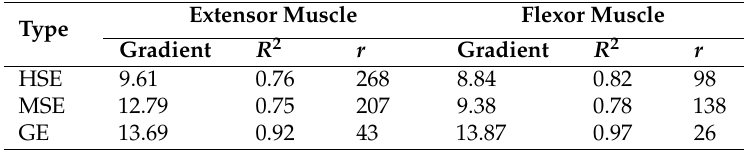
Table 3. Linear regression values for SEMG data of all participants over five